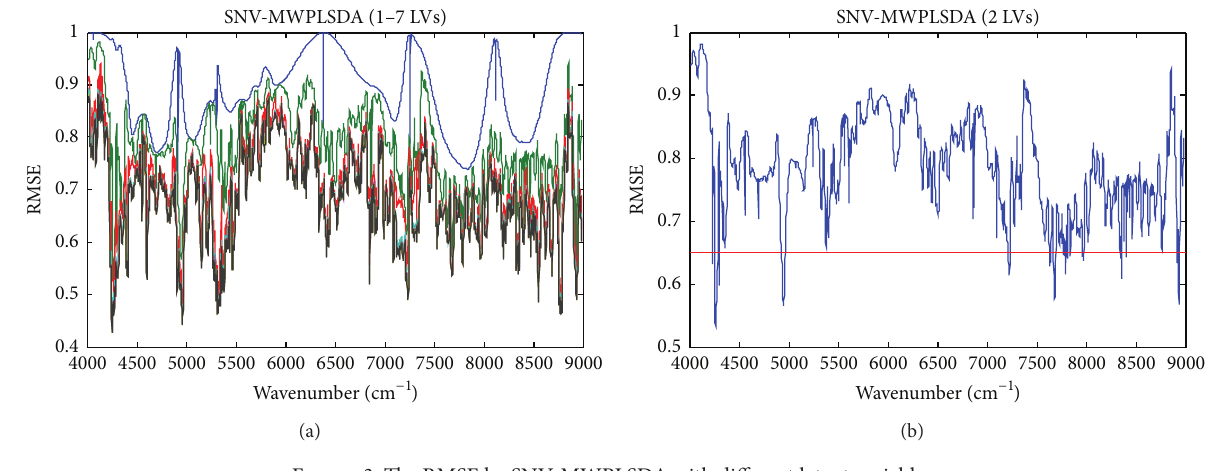
Figure 3: The RMSE by SNV-MWPLSDA with different latent